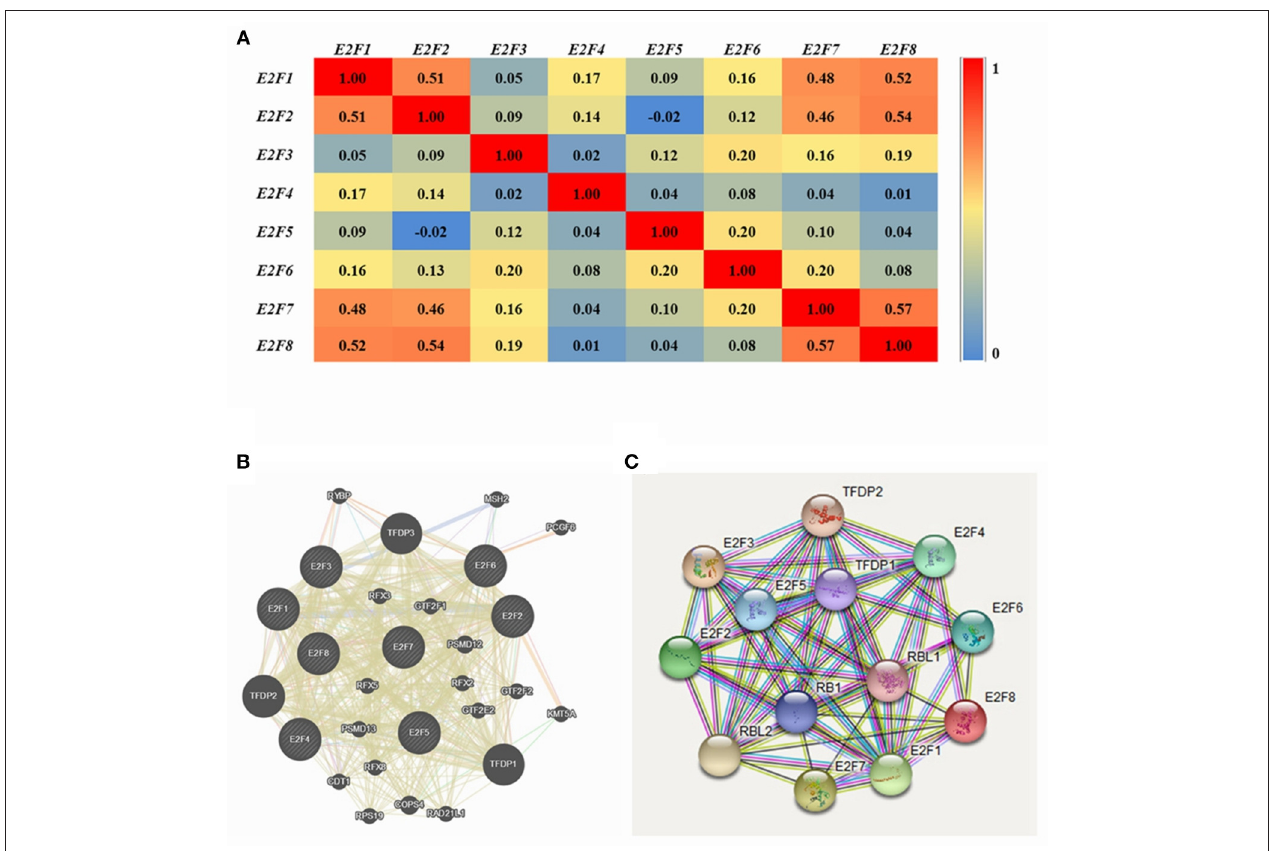
FIGURE 4 | Co-expression and interaction analysis of E2F family members at the gene and protein levels in patients with OC (cBioPortal and GeneMANIA). (A) Pearson correlation of E2F family members. (B) Gene–gene interaction network among E2F family members in the cBioPortal dataset. (C) Protein–protein interaction network among E2F family members in the GeneMANIA